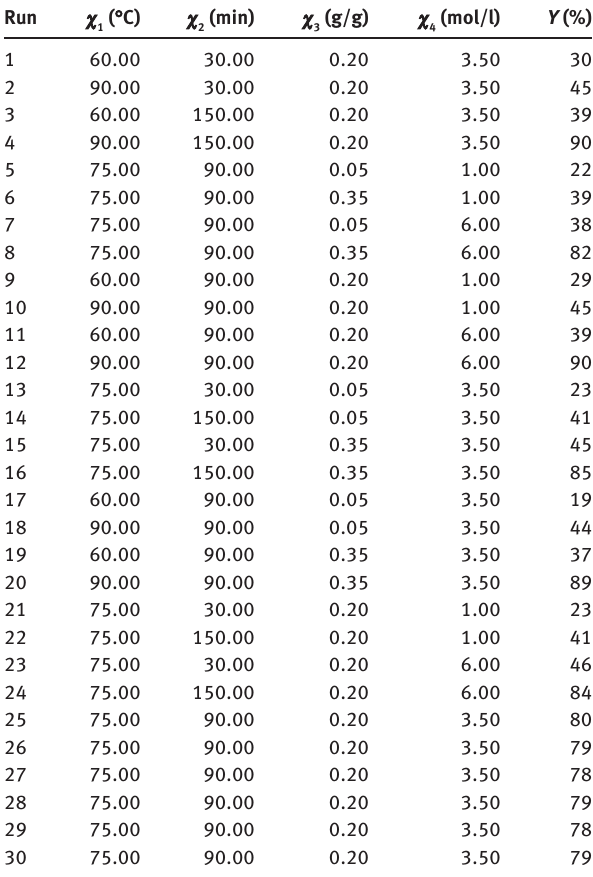
Table 3: Central composite design arrangement and